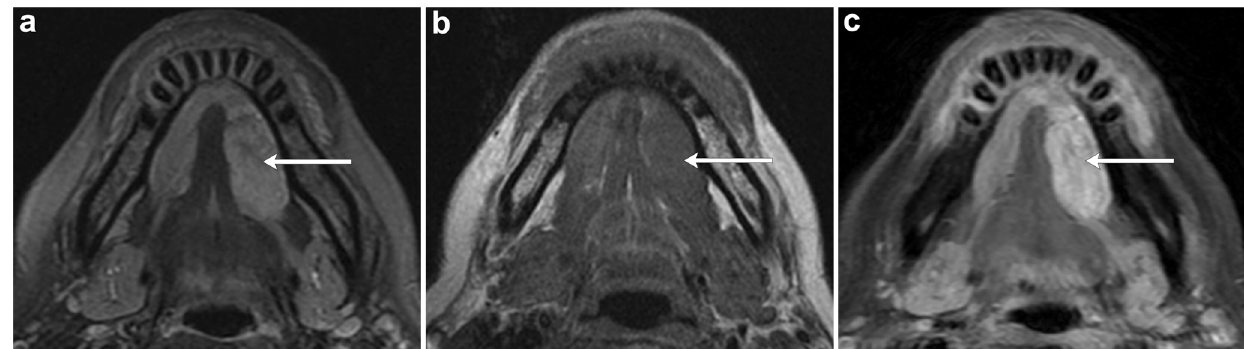
enlarging and distorting the left sublingual gland ( arrow ). c There is diffuse enhancement on the axial post-contrast T1-weighted MR image